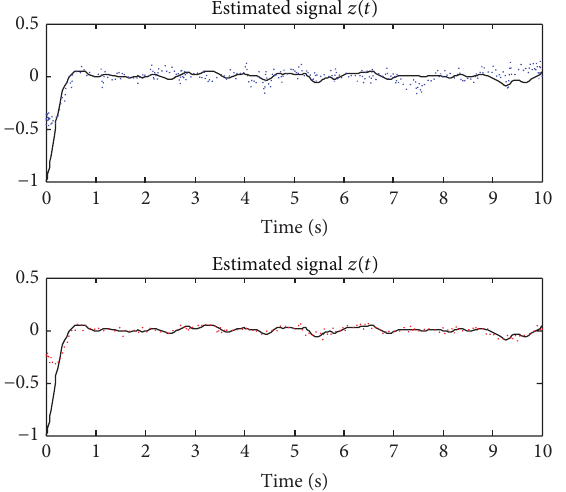
Figure 4: Filtering results for random noise